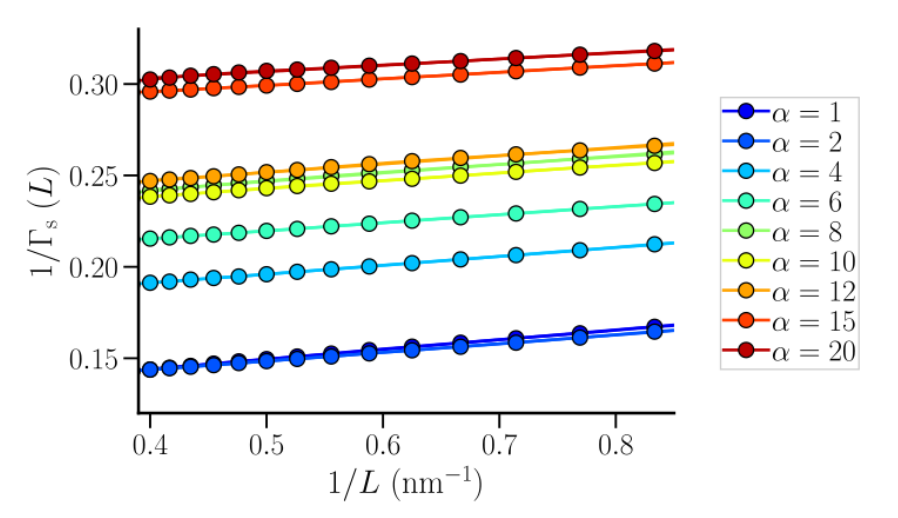
Figure 5. 1/ Γ s ( L ) profiles for the first polymer hydration shell for different values of the repulsive interaction parameter α . The lines are linear fits to the data in the range L = 1.2–2.5